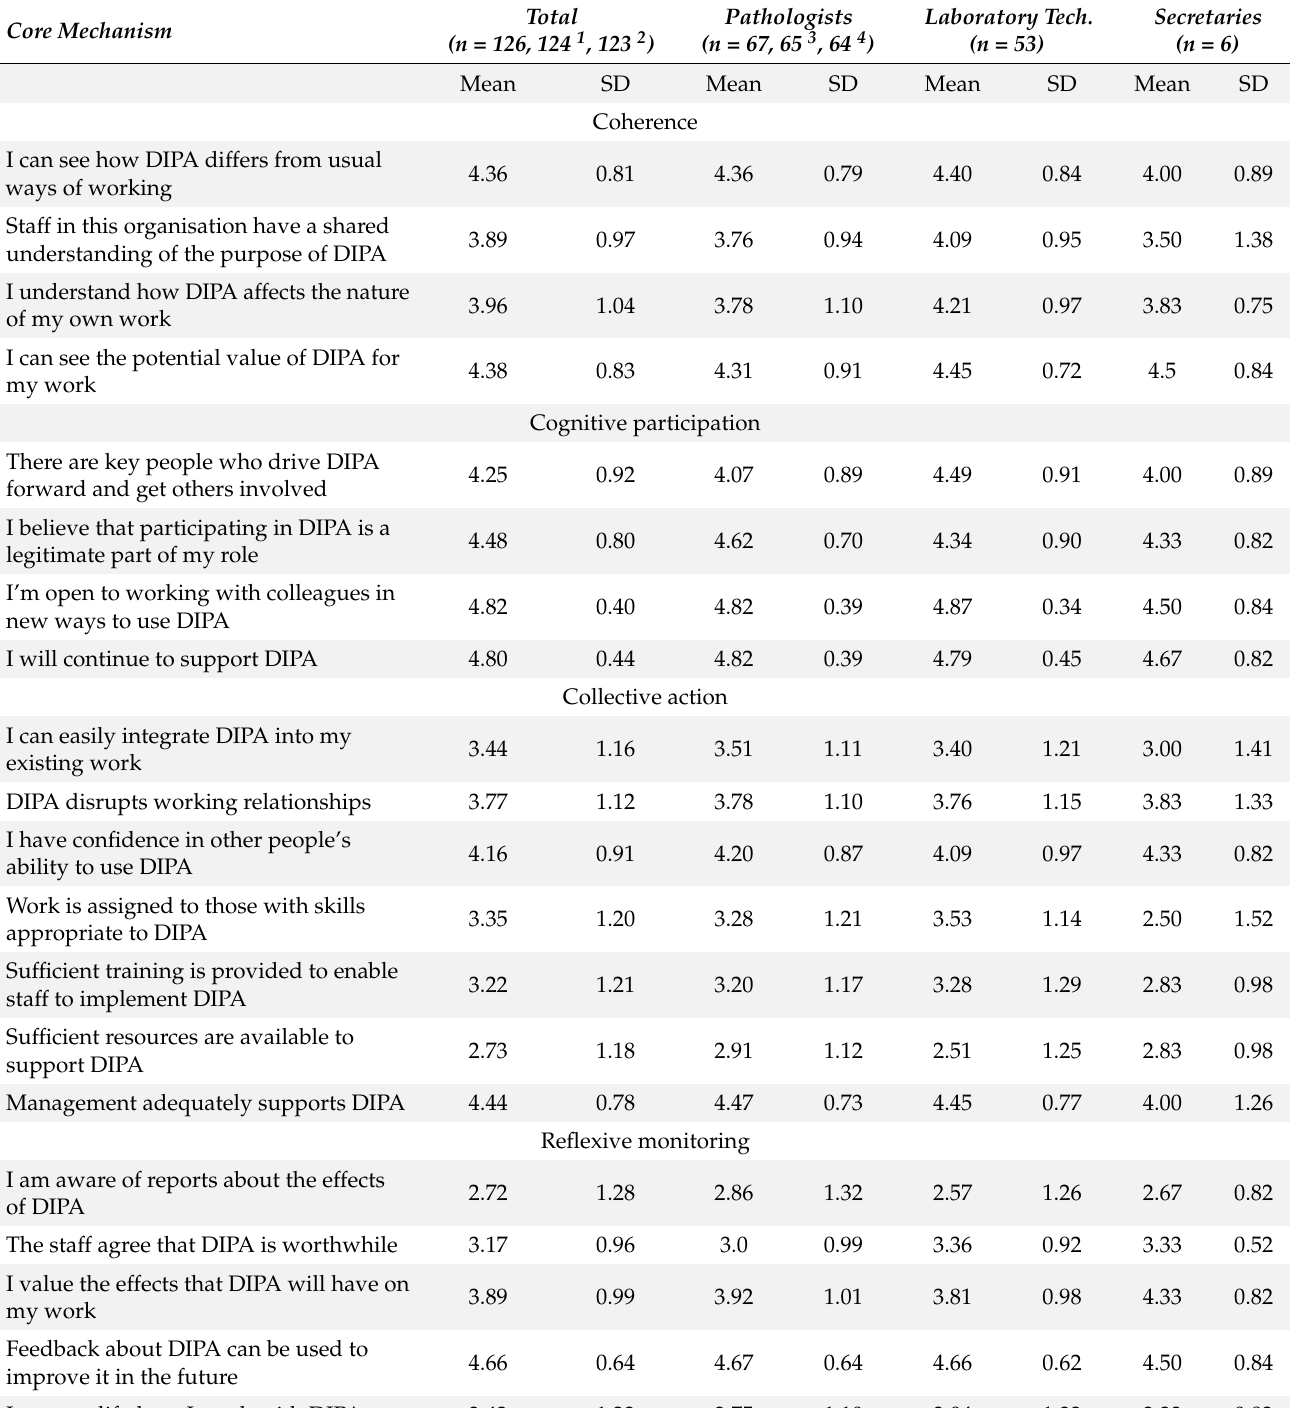
Table A2. Core mechanism